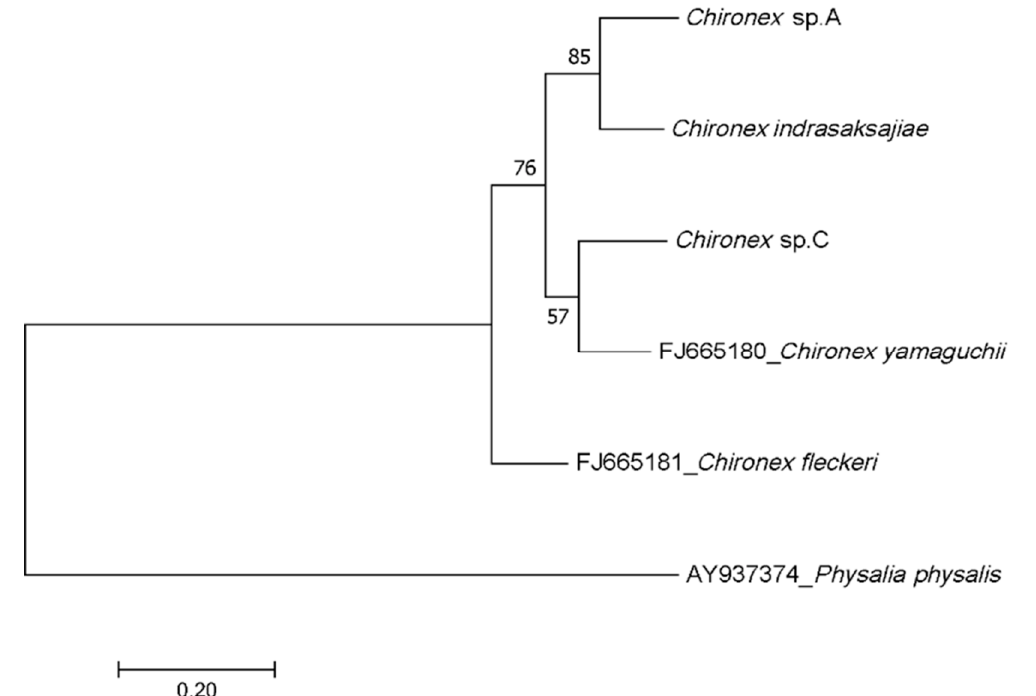
Figure 3. Phylogenetic tree of Chironex species based on the COI gene sequences.